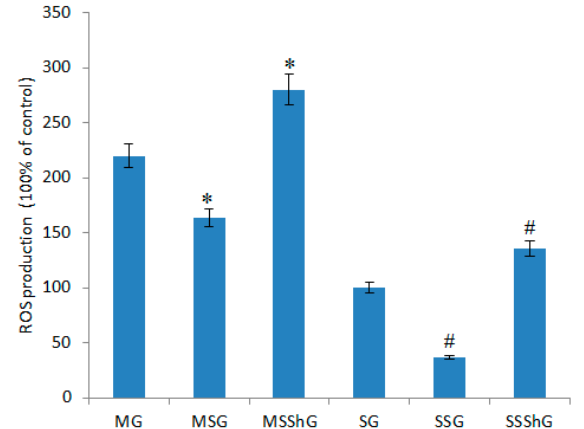
Figure 3. ROS production in different cells. Among 16 mice, eight mice were used to create RIRI models as a model group and eight mice were used as a sham group. Renal progenitor cells were isolated from the kidney cortex of RIRI model and sham mice after 16-h surgery. For the kidney cells isolated from eight model mice, they were further subdivided into three groups based on different treatment options (model group (MG); STC-1 expression group (MSG), the mice were transfected with STC-1 gene to overexpress STC-1; and STC-1 shRNA group (MSShG), the mice were transfected with STC-1 shRNA to knockdown STC-1). In the same way, the kidney cells from eight sham mice were subdivided into another three groups based on different treatment options sham groups (sham group (SG); STC-1 expression group (SSG), the mice were transfected with STC-1 gene to overexpress STC-1; and STC-1 shRNA group (SSShG), the mice were transfected with STC-1 shRNA to knockdown STC-1). The ROS levels were measured from all the cells cultured for 24 h. All data were presented as the mean values ± S.D. * p < 0.05 via a model group and # p < 0.05 via a sham group.